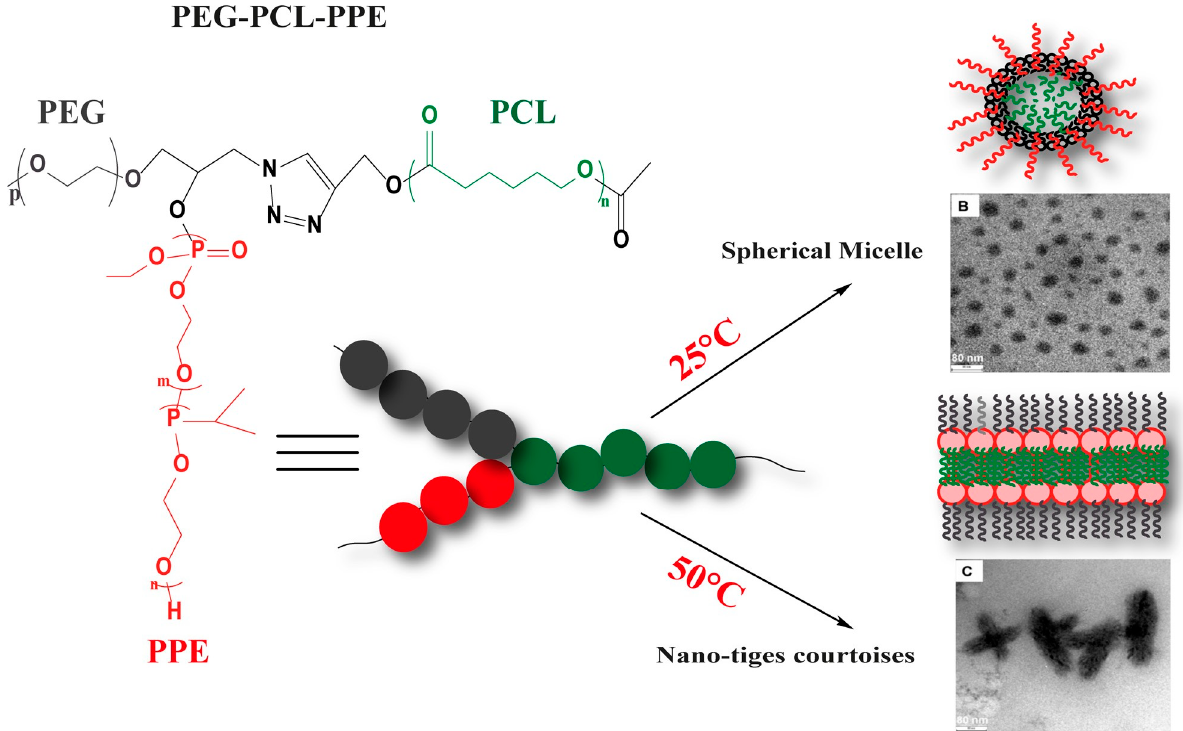
Figure 19. Ability of multi-arm copolymers to alter their morphology based on temperature; TEM analyses of ABC terpolymer assemblies in aqueous solution at 25 °C ( B ), and after heating to 50 °C for 72 h ( C ). Adapted from [205] (Copyright 2011, Elsevier).